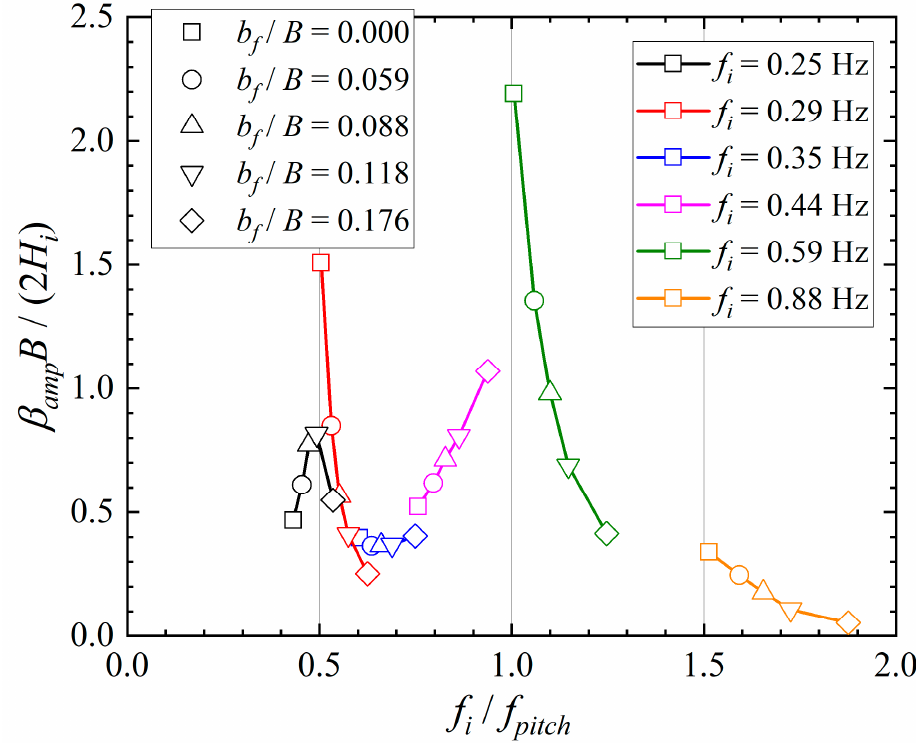
i ) and b f / B for the pitch motion.